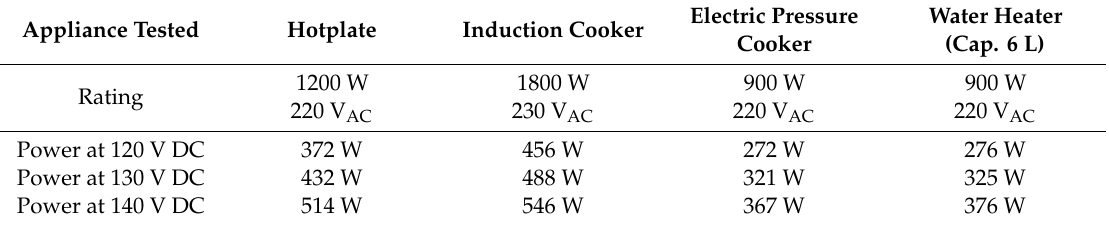
Table 1. Power consumptions of di ff erent cooking appliances at di ff erent voltage